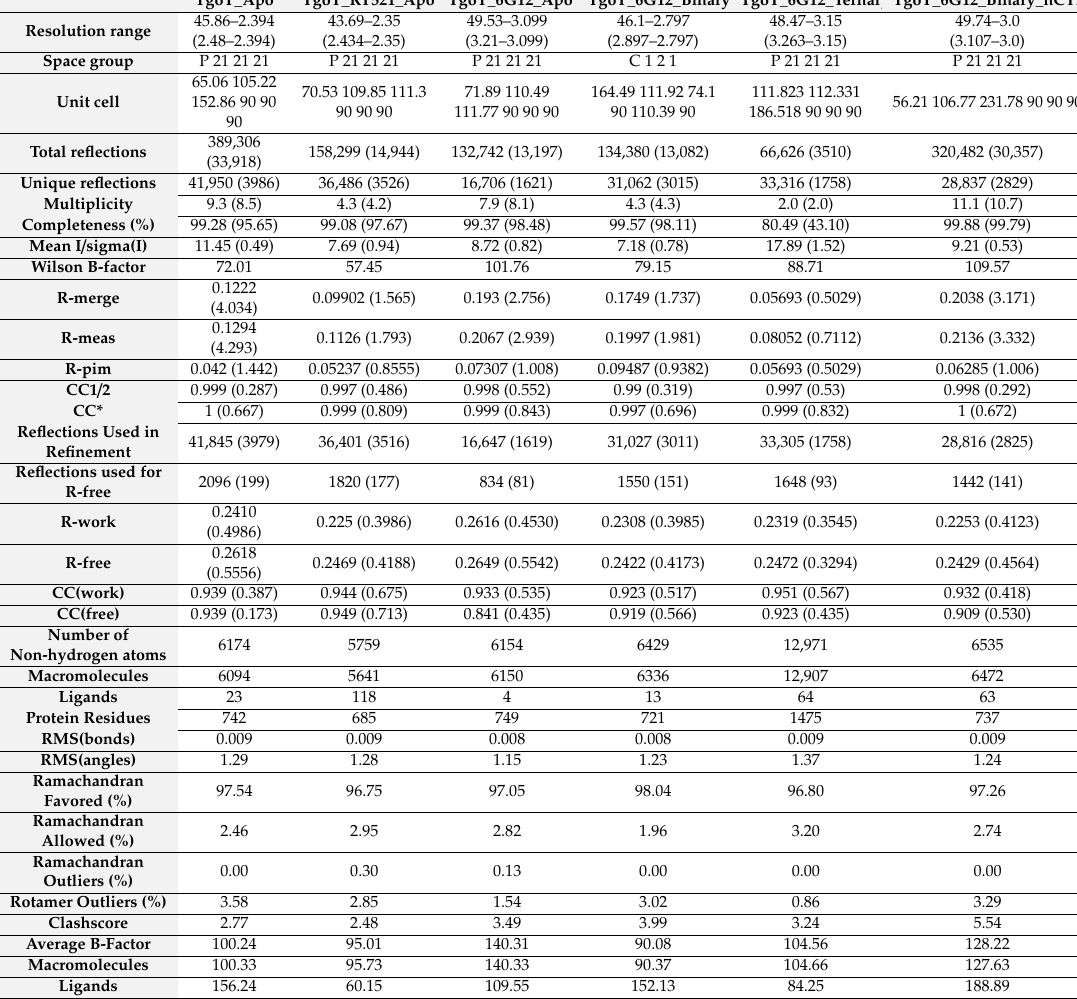
Table 2. Di ff raction data processing and refinement